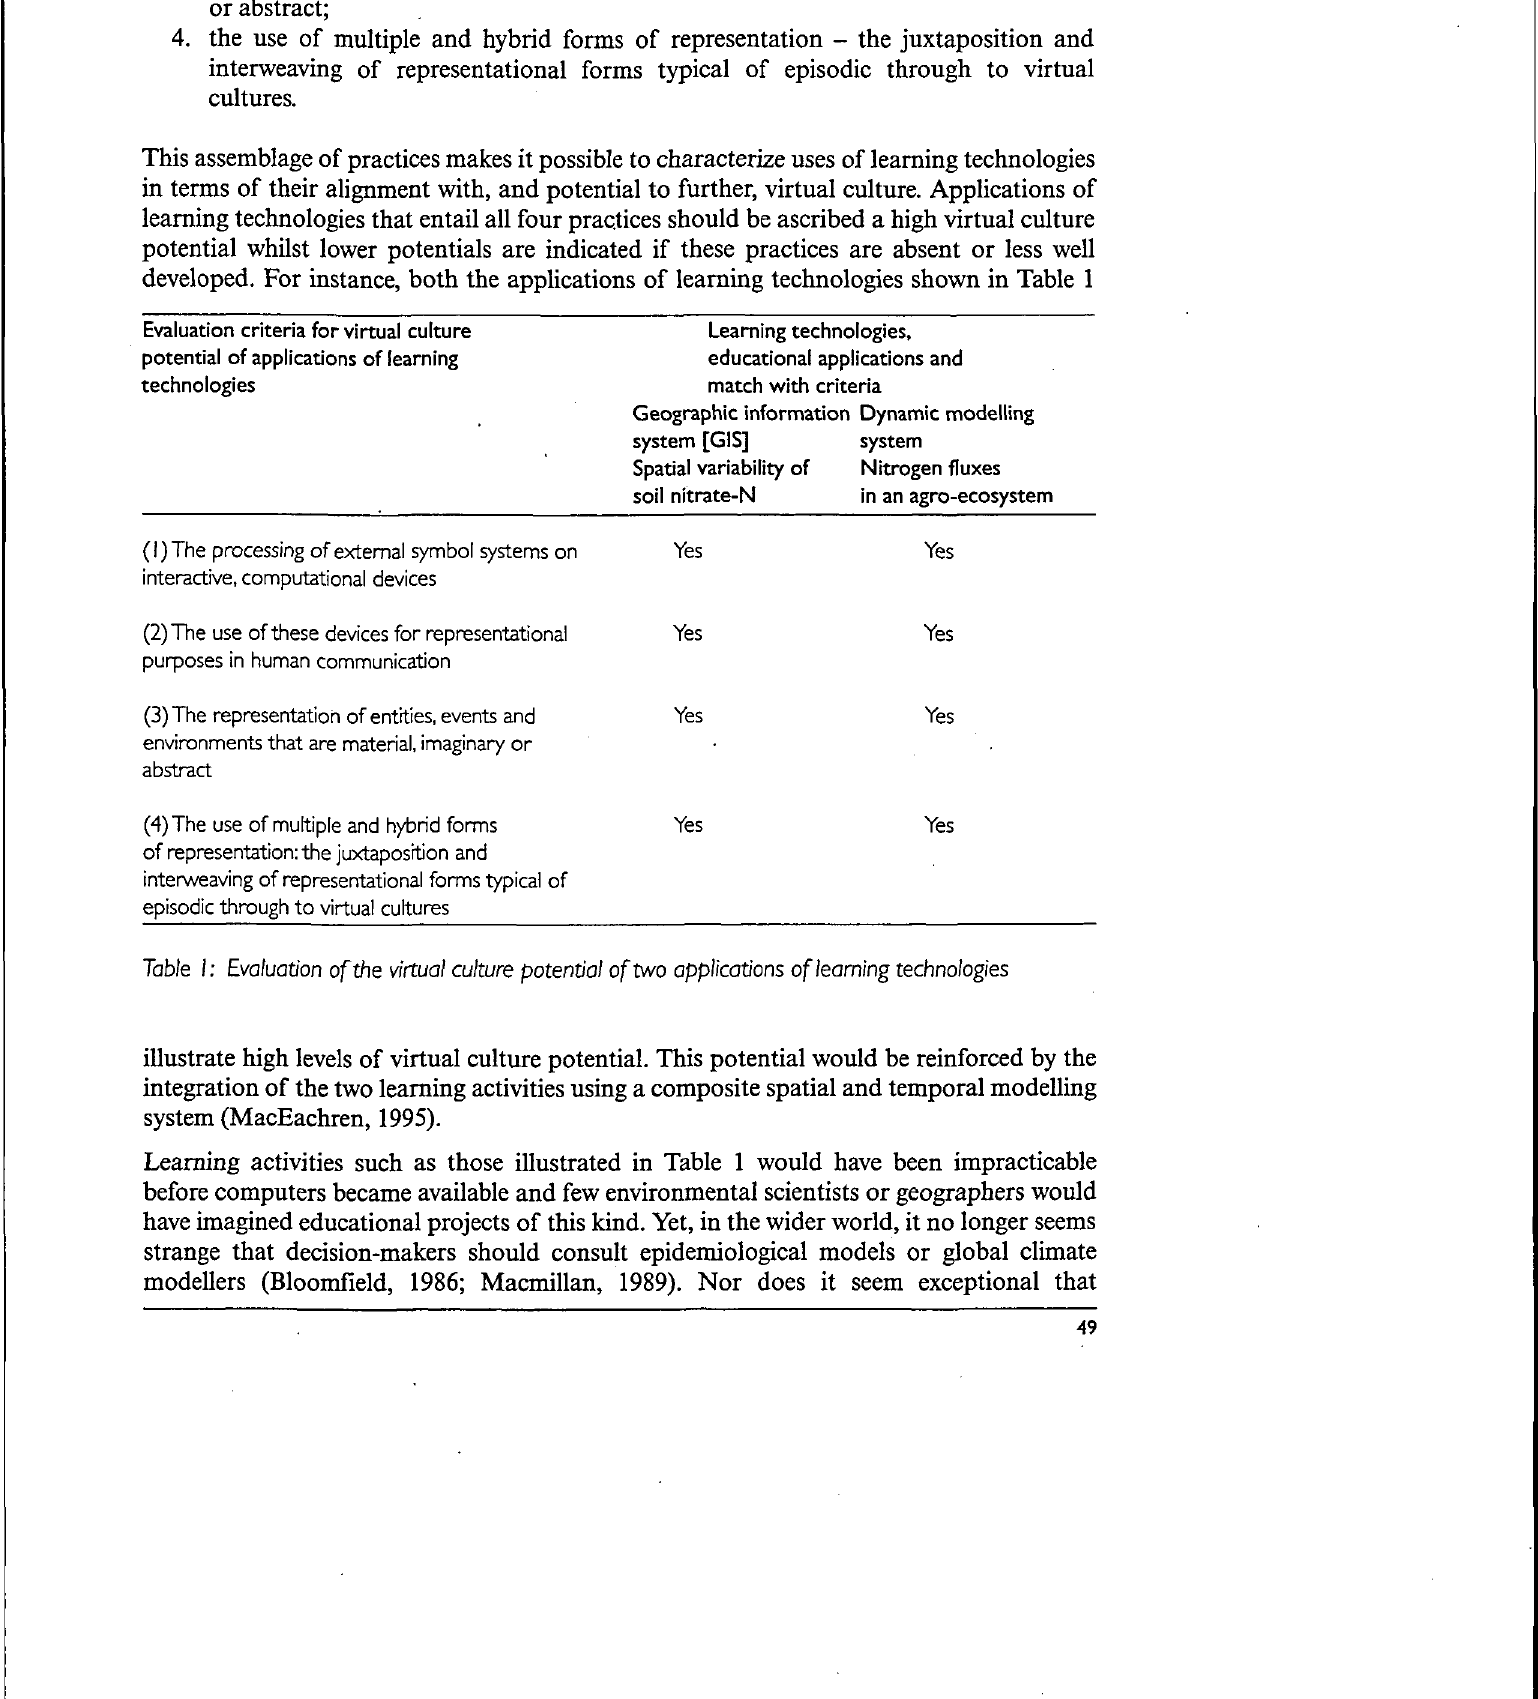
illustrate high levels of virtual culture potential. This potential would be reinforced by the integration of the two learning activities using a composite spatial and temporal modelling system (MacEachren,